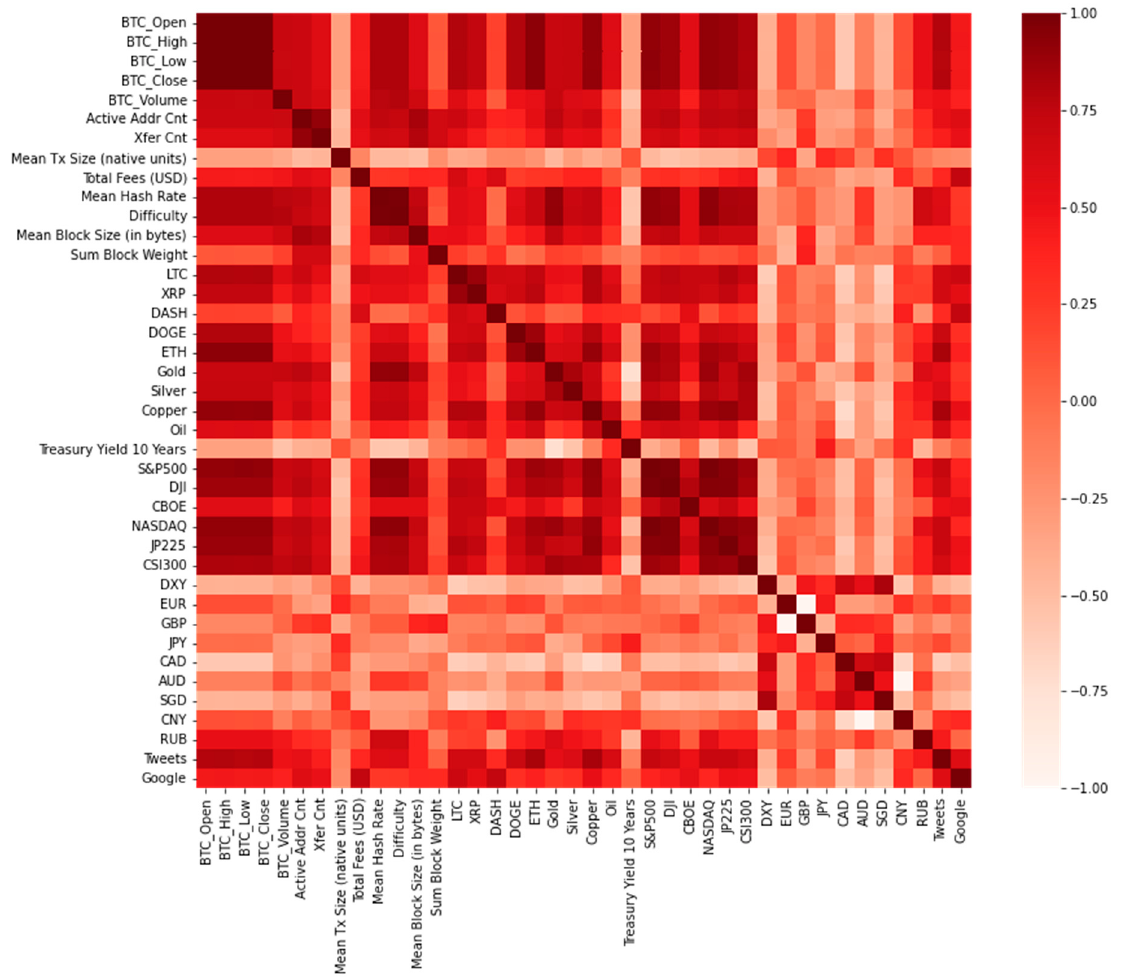
Figure 4. Correlation heatmap of explanatory variables.